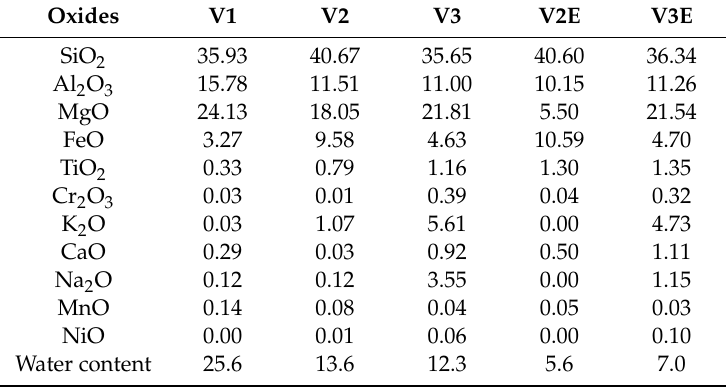
Table 1. Chemical analyses (wt%) and water content of the starting vermiculites and thermoexfoliated vermiculites